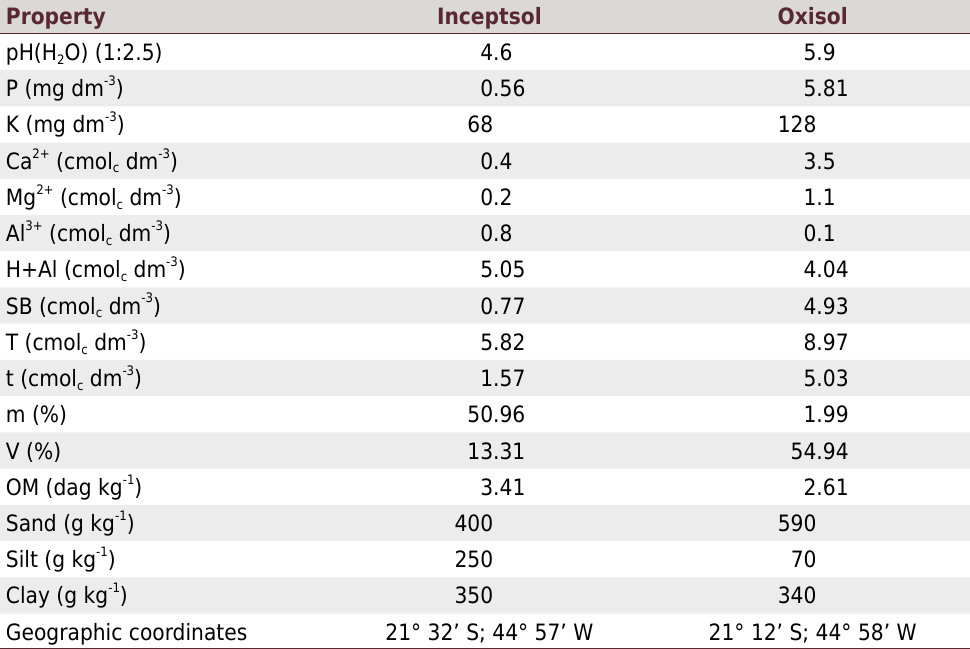
Table 2. Chemical and physical properties of soil samples, taken at the 0.00-0.20 m depth layer, and geographic coordinates of the collection sites